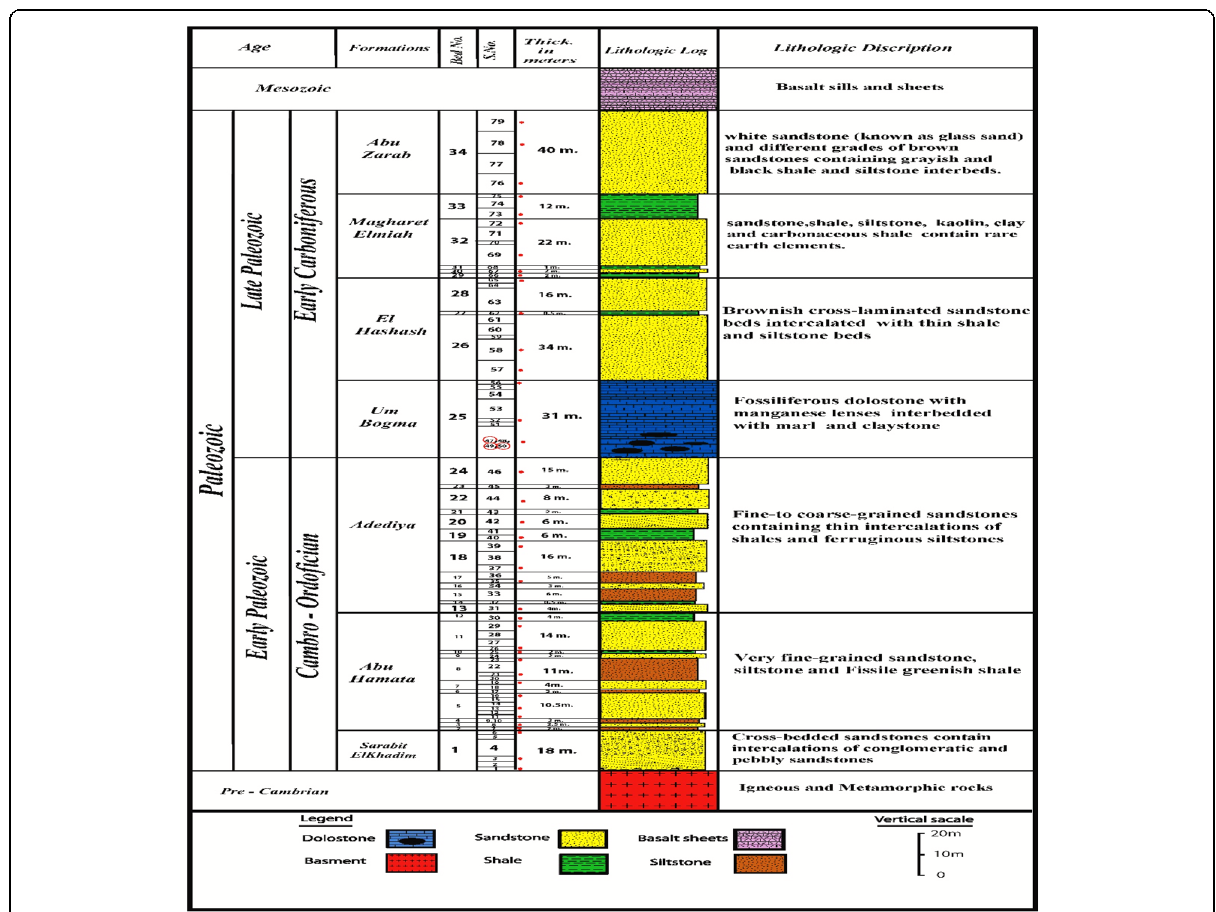
Fig. 2 Composite columnar lithologic section of Paleozoic sedimentary formations in southwestern